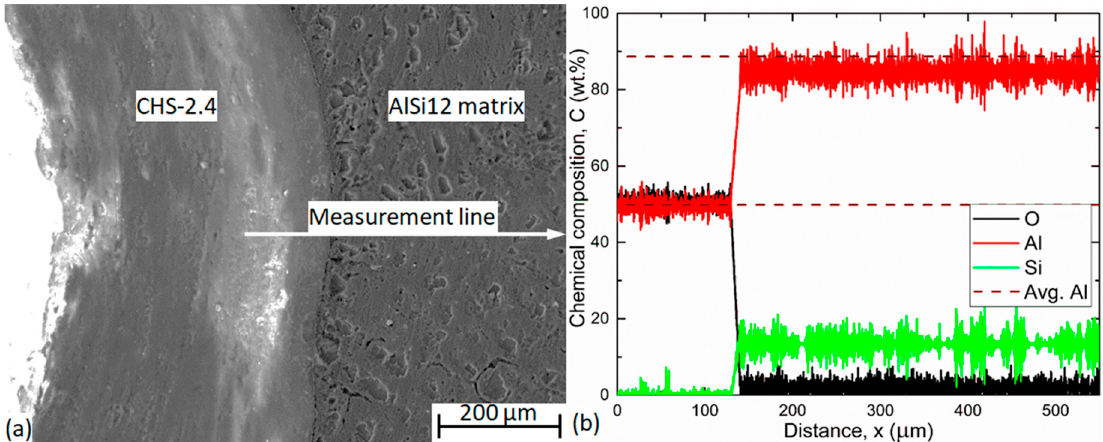
Figure 5. SEM picture ( a ) with the line used for the line energy-dispersive X-ray spectroscopy (EDS) measurement (red arrow) and ( b ) line EDS measurement result for the CHS-2.4 grade fillers. Table 5. Boundary layer thickness values between AlSi12 matrix and the filler materials.